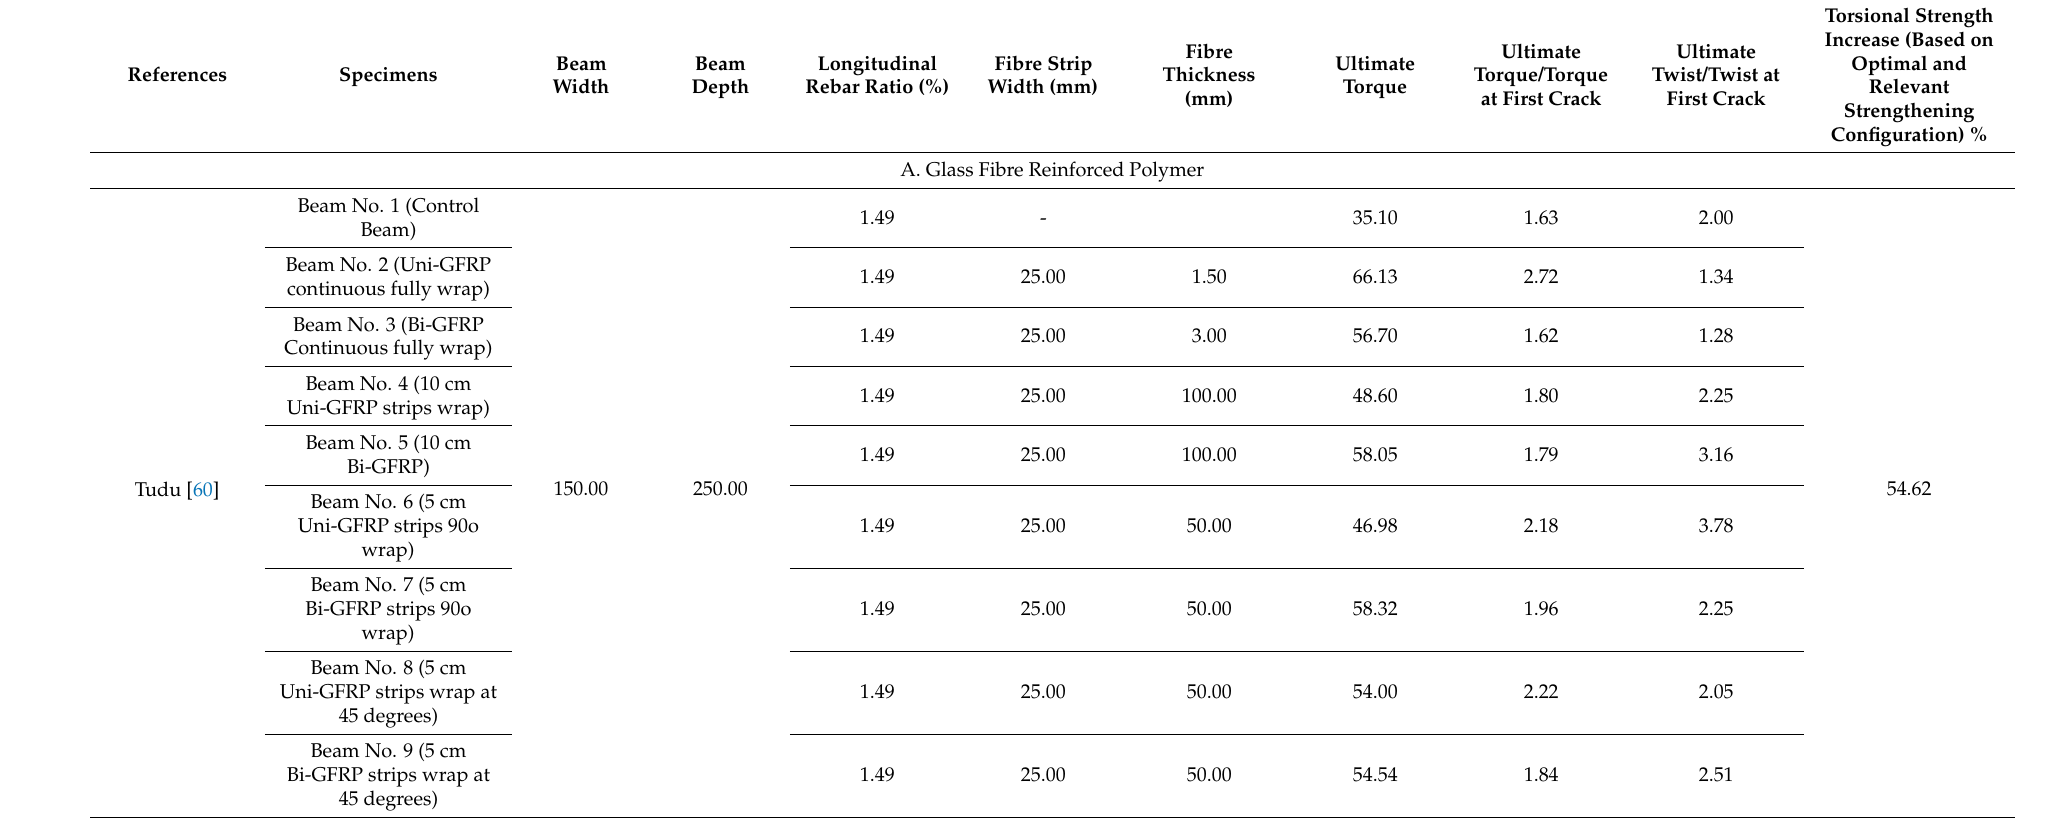
Table 11. Experimental findings on glass fibre reinforced polymer